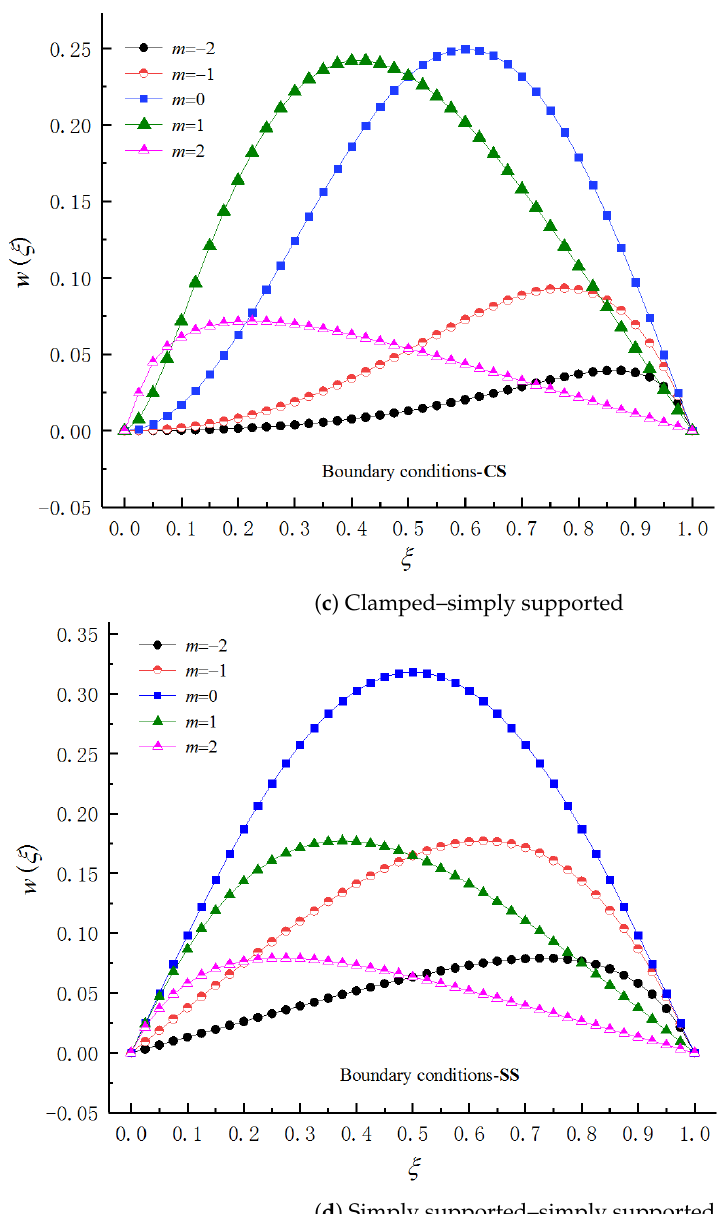
Figure 2. The buckling mode shape of axially functionally graded material Timoshenko